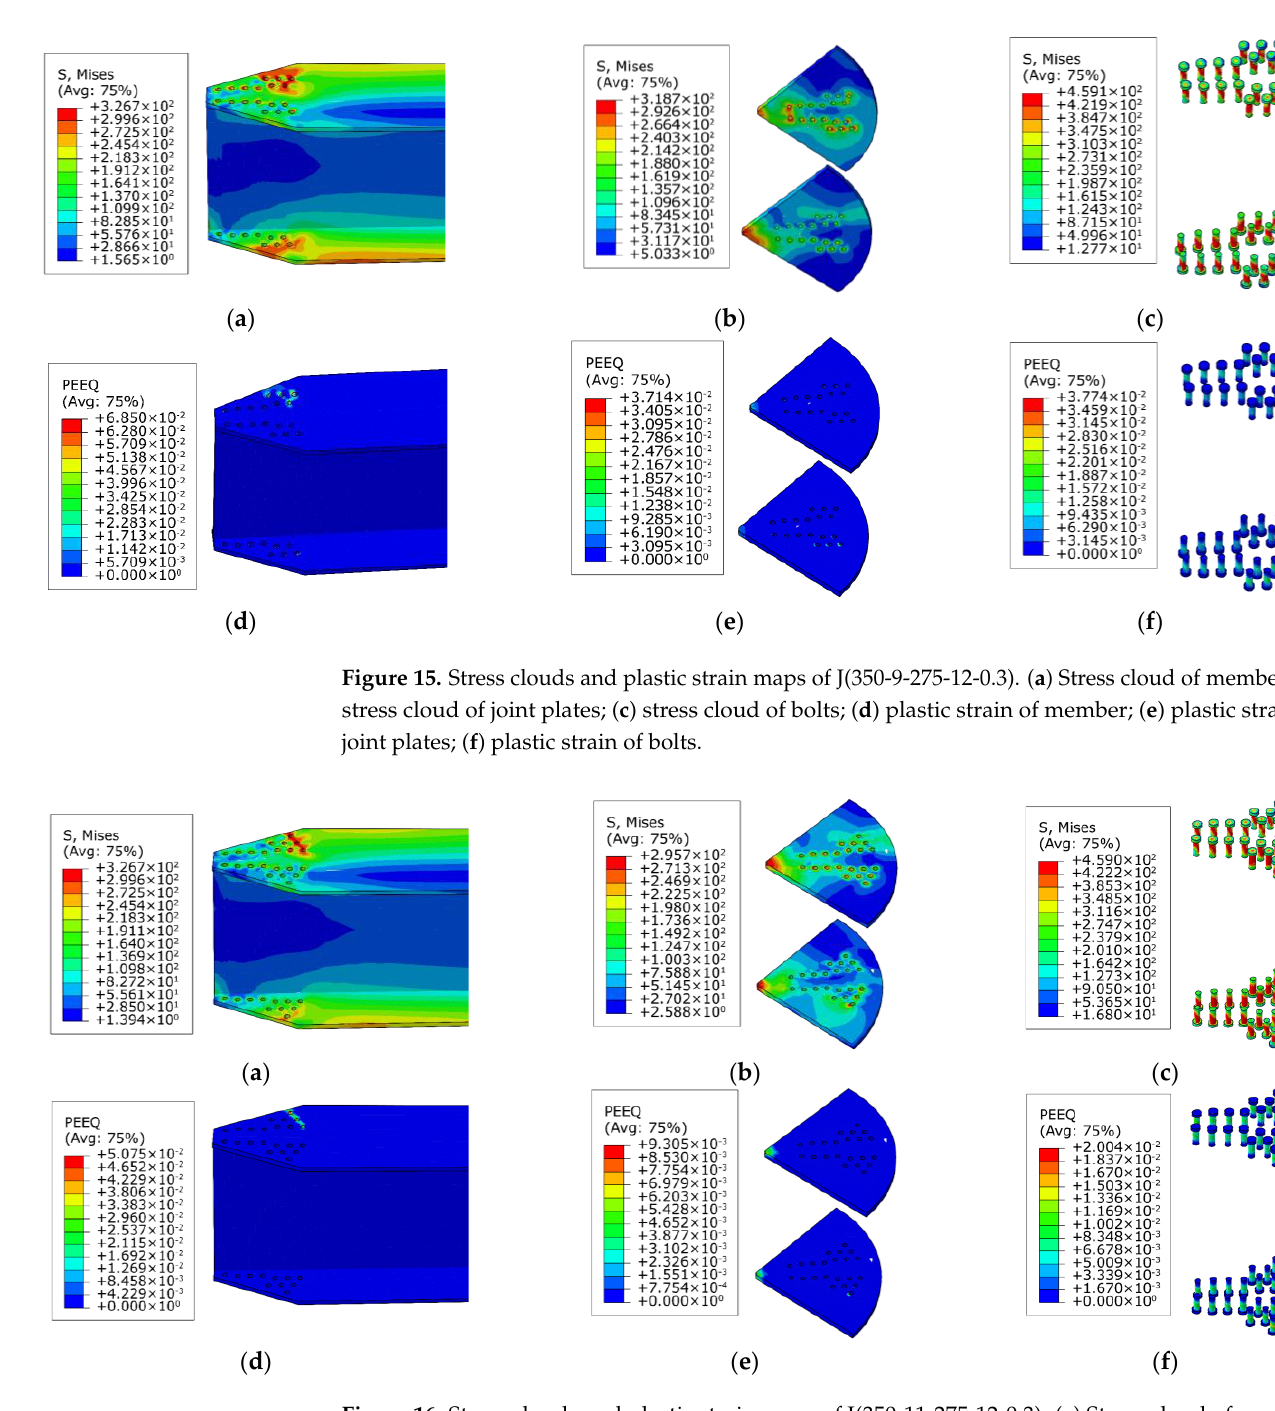
Figure 14. Effect of the number of bolts. ( a ) Out-of-plane M–φ curve; ( b ) in-plane M–φ curve.